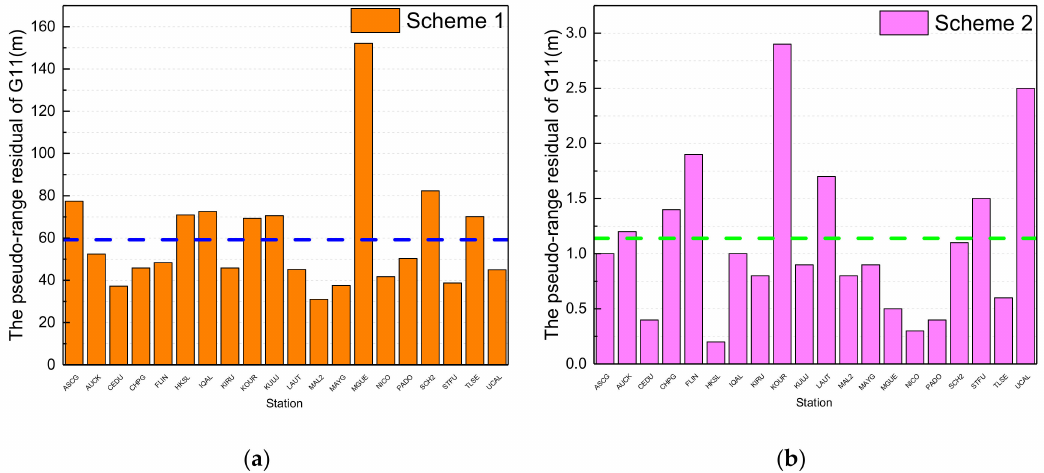
Figure 7. Pseudo-range residuals of stations for G11 in the first adjustment for data processing on 1 March 2018: residuals from precise orbit determination according to ( a ) scheme 1 and ( b ) scheme